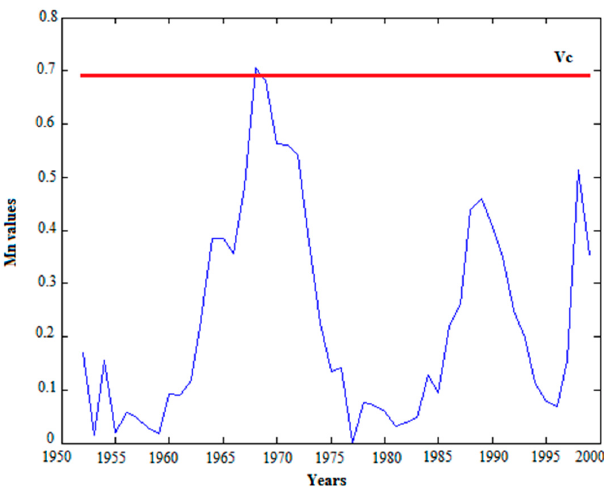
Figure 2. Temporal variability of M n values derived for the link between AMO and Tmin at the Mont-Joli station (1950–2000).